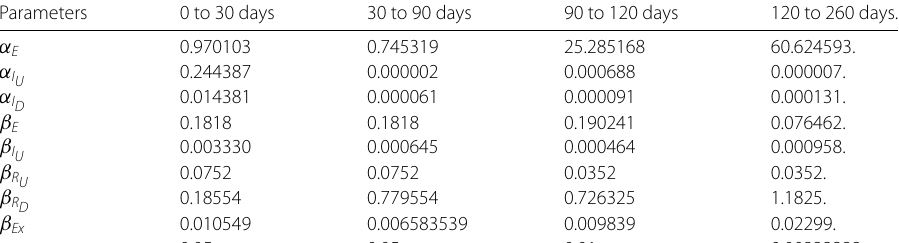
Table 2 Estimated parameters of model (1)–(8), taking into account different control stage measures Parameters 0 to 30 days 30 to 90 days 90 to 120 days 120 to 260 days. α E 0.970103